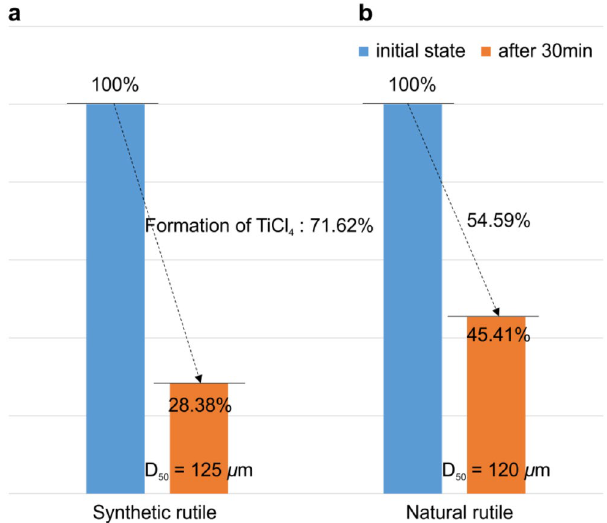
Figure 3. Weight change rate of synthetic rutile and natural rutile after chlorination.